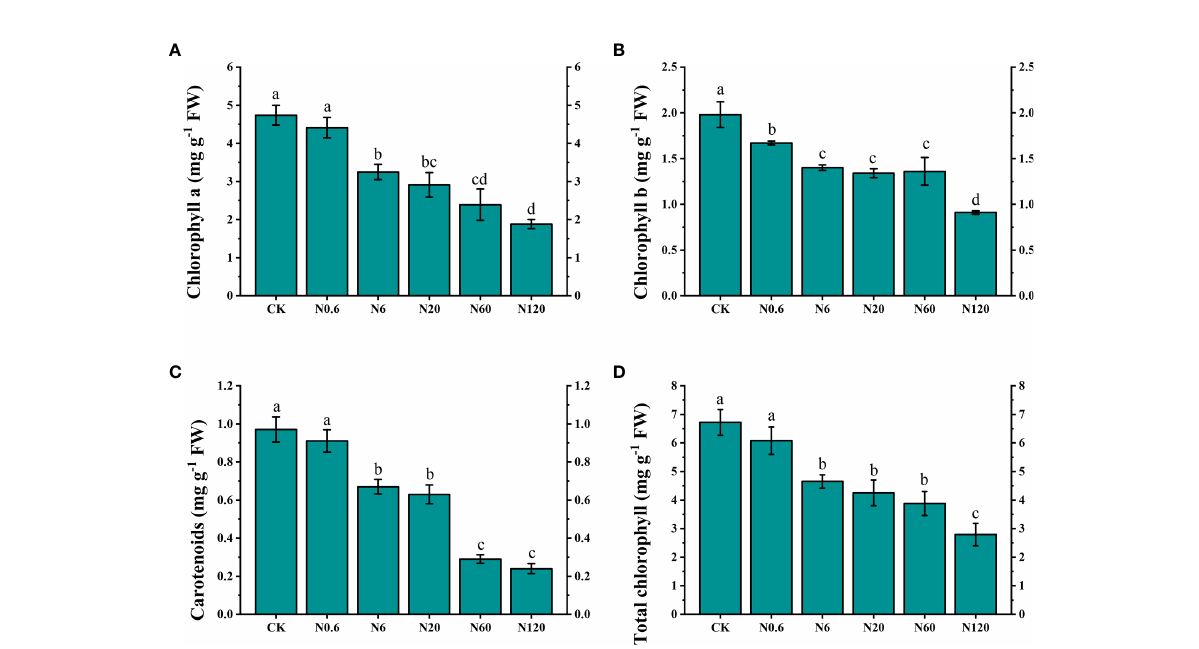
FIGURE 3 Effects of nicosulfuron on the photosynthetic pigment of sugar beet leaf. Chlorophyll a (A) , chlorophyll b (B) , carotenoids (C) and total chlorophyll (D) in sugar beet on 20 DAT with different doses of nicosulfuron. FW: fresh weight. Data with the different letters indicate signi fi cant differences between different doses of nicosulfuron drift (n = 6, p <